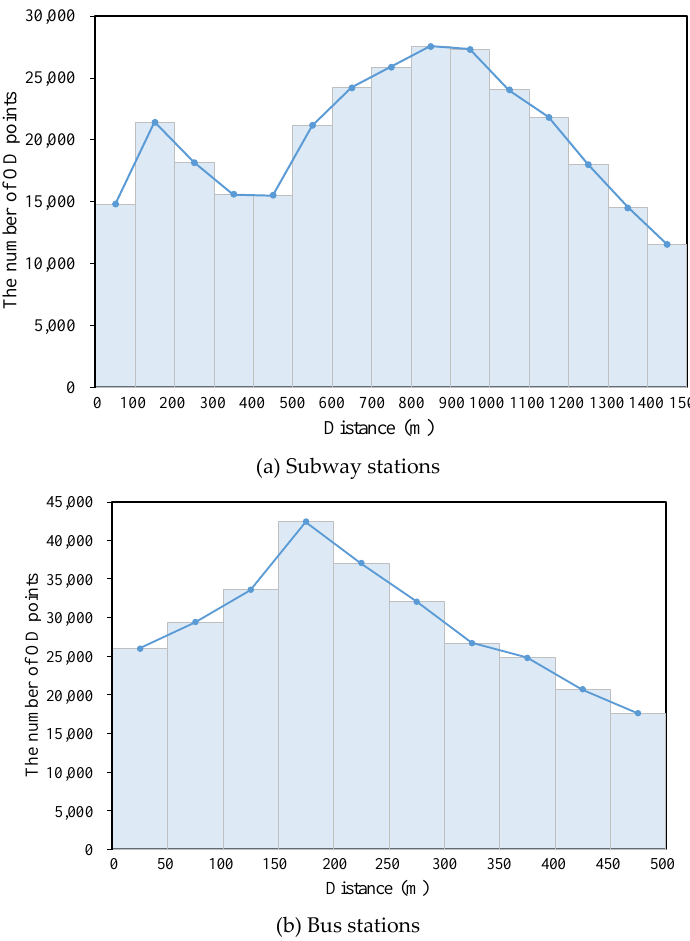
Figure 7. The number of origin and destination (OD) points around the subway and bus stations